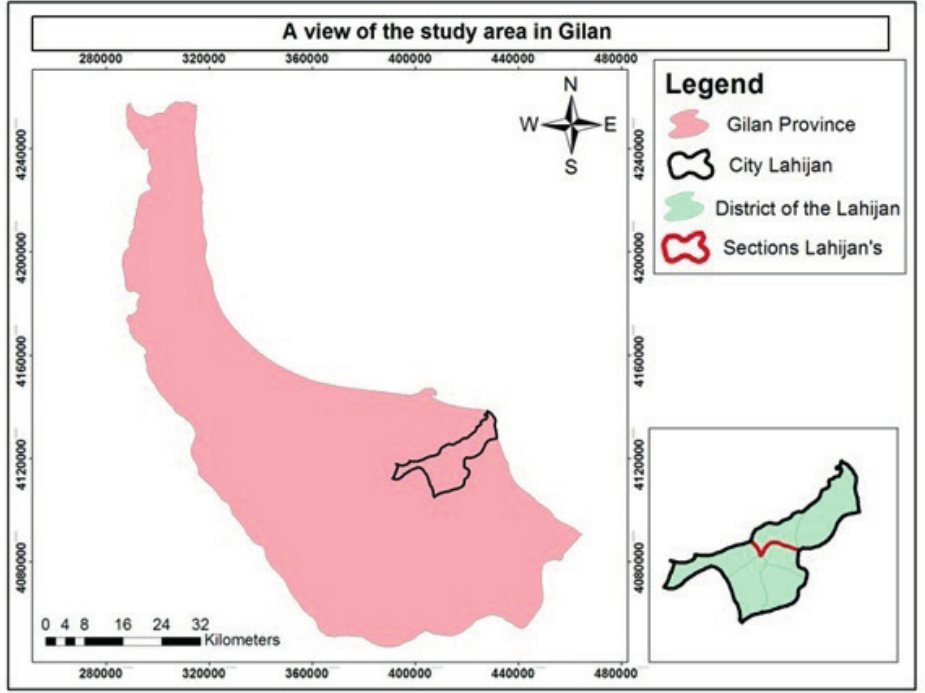
Figure 1 - Lahijan County and its districts in Gilan